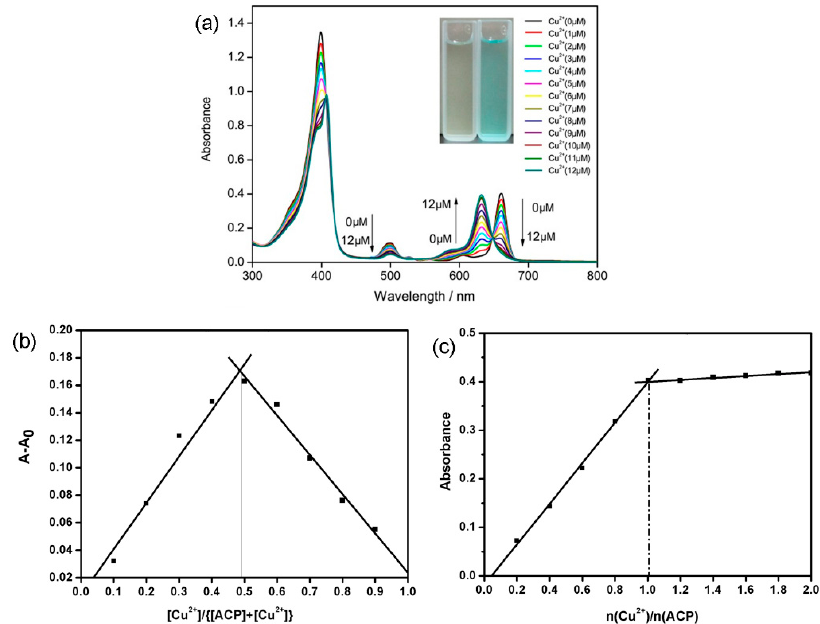
Figure 1. ( a ) The absorption spectrum of ACP in water/ethanol ( v / v = 50/50) solution (10 µ M) with added Cu 2+ ; ( b ) Job’s plot according to the method for continuous variations (the total concentration of ACP and Cu 2+ is 10 µ M. The absorbance was measured at 632 nm; ( c ) Mole ratio plot for stoichiometric ratio between ACP (10 µ M each) and Cu 2+ .